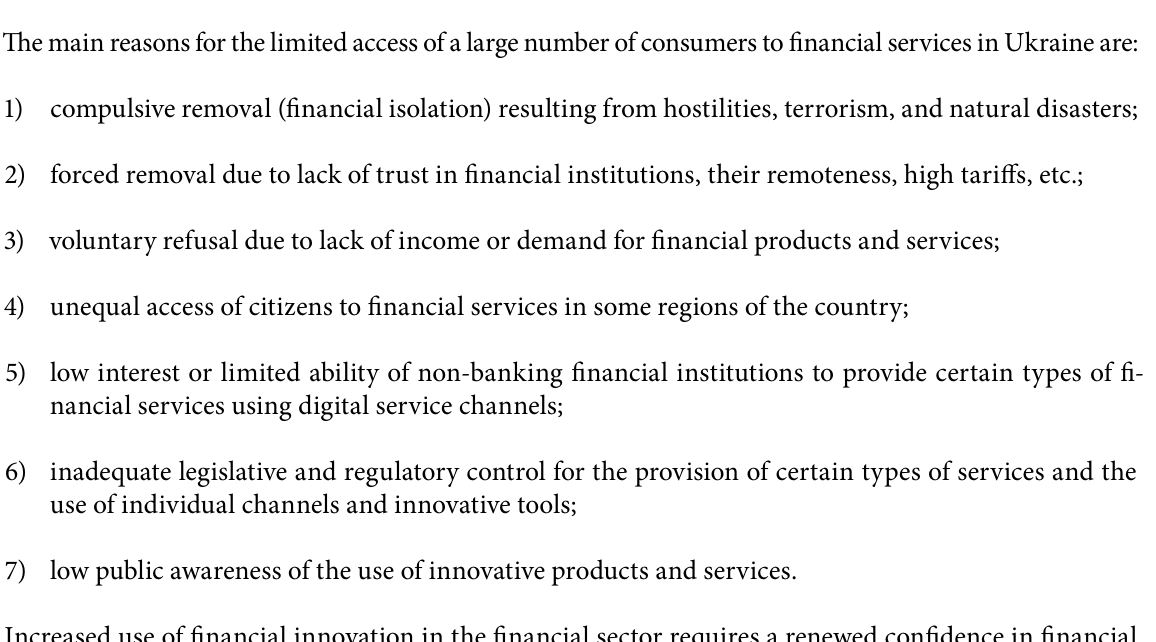
Financial services availability: using traditional channels and